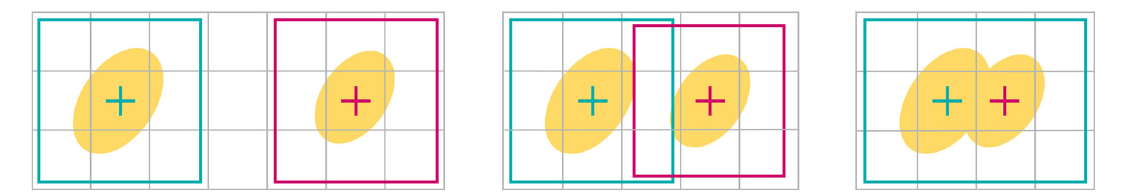
Fig. 3 Diagram representation of π 0 cluster cases on the calorimeter. From left to right: the two photons are separable and without overlap, it is a resolved π 0 . The two photons are separable but have three over-